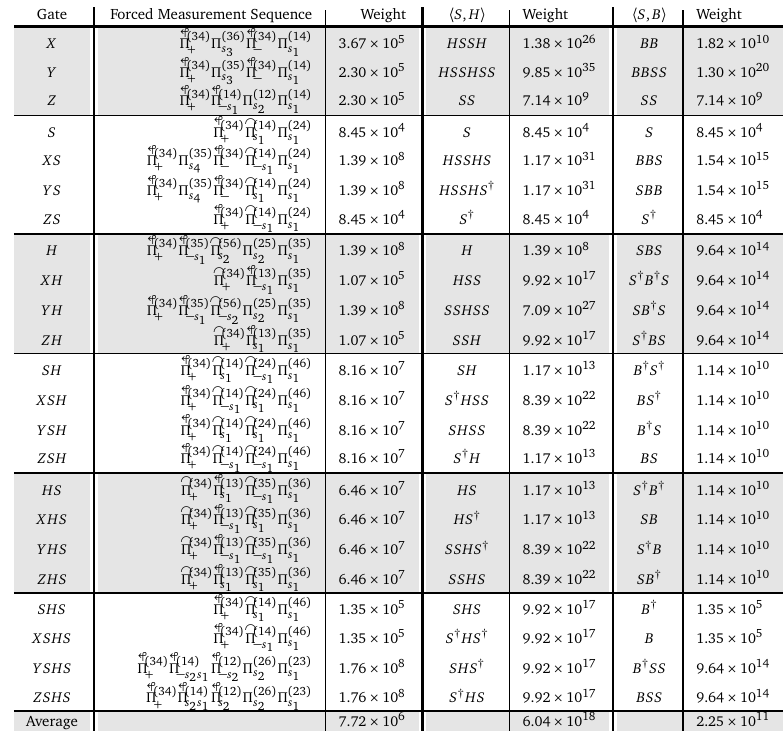
Table 5: Minimal difficulty weight measurement sequences for each single-qubit Clifford gate when using forced-measurement methods. For comparison, we also present the corresponding realization of the gates formed by using the generating gate sets 〈 S , H 〉 and 〈 S , B 〉 .